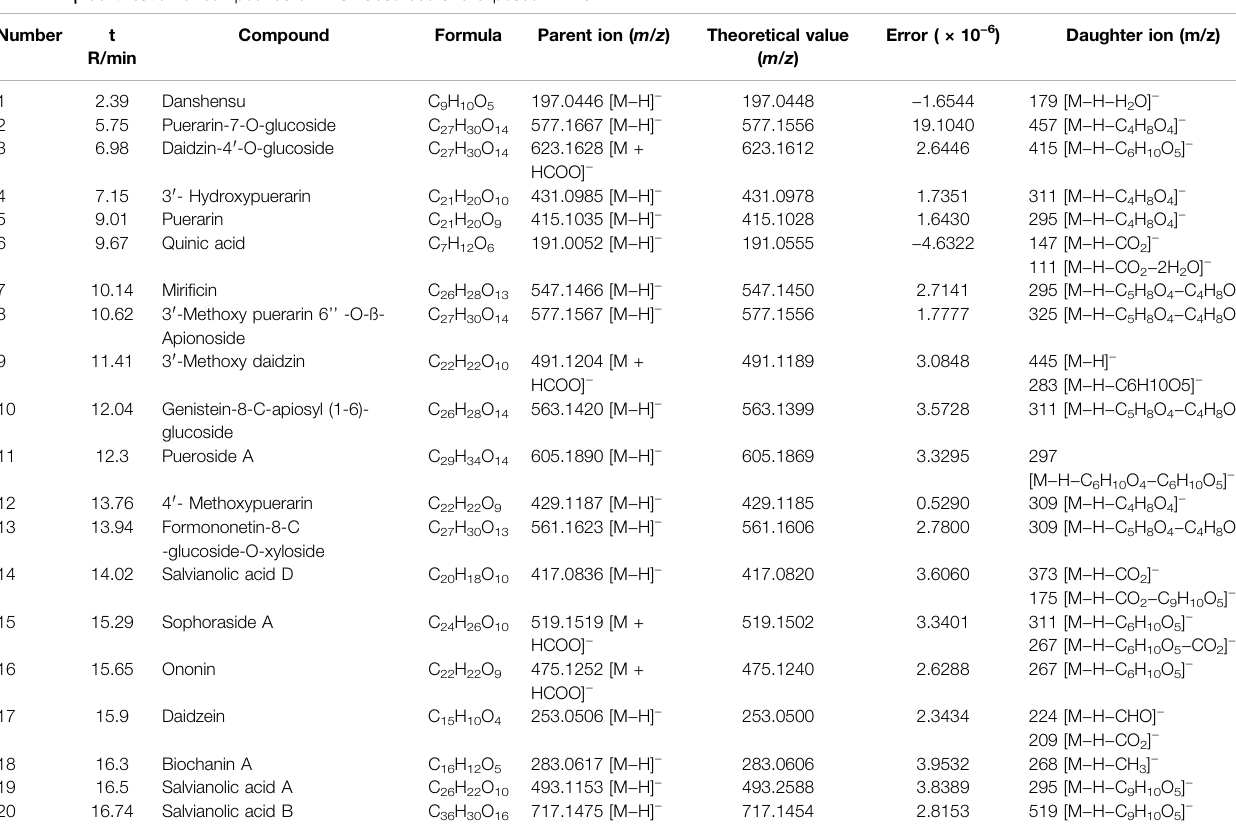
TABLE 4 | Identi fi cation of compounds of XKST absorbed and exposed in